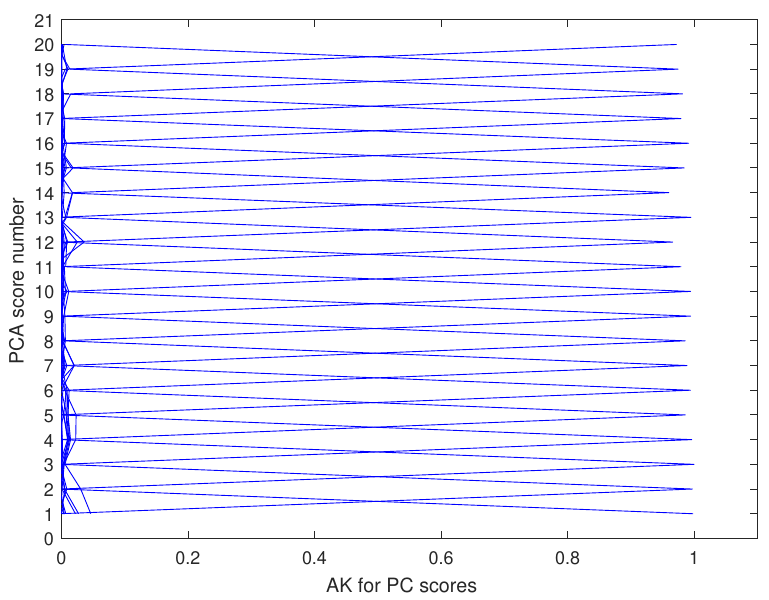
Figure 10. Example of Averaging Kernels for the twenty PC scores in the retrieved state vector. The example corresponds to one of the IASI soundings in Figure 2.